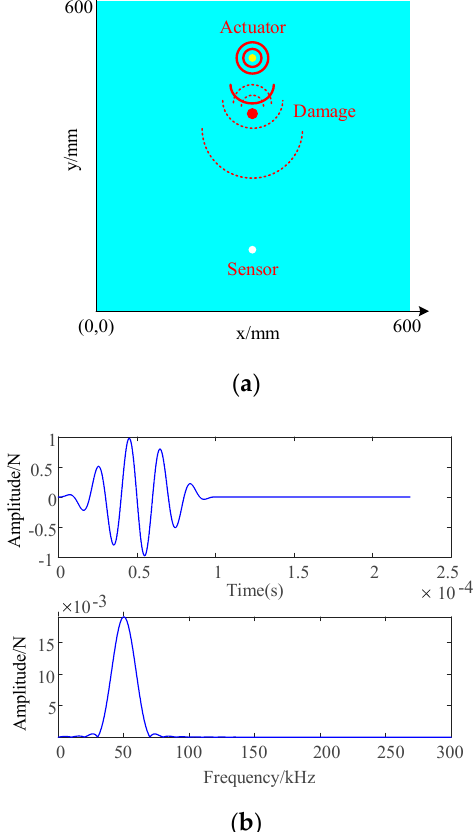
Figure 1. ( a ) Schematic diagram of actuator and sensor position; ( b ) high frequency excitation signal.